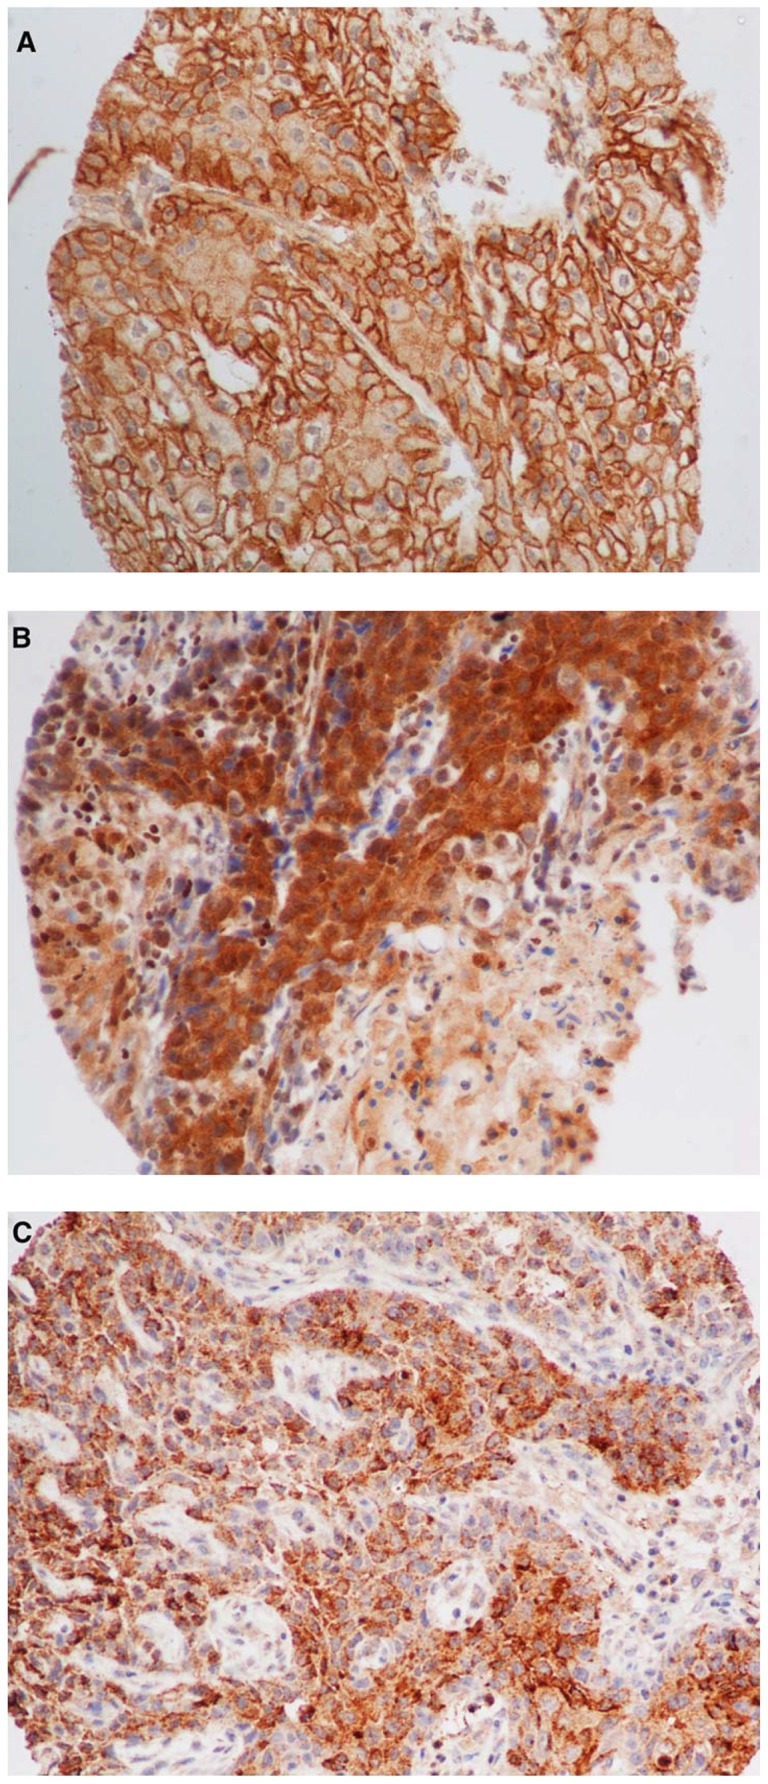
Illustrative examples of immunohistochemical expression and immunoreactive score (IRS) evaluation on tissue-microarray cores.A. IGF1R-alpha strong membraneous staining in 100% of cancer cells (IRS = 9); B. IGF1R-beta strong cytoplasmic staining in 80% of cancer cells (IRS = 9); C. IGF2R strong cytoplasmic and membraneous staining in 80% of cancer cells (IRS = 9). All pictures: magnification X 40.